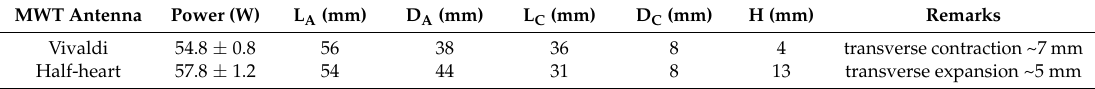
Table 1. Characteristic dimensions of the ablation zone achieved in the MTA experiments